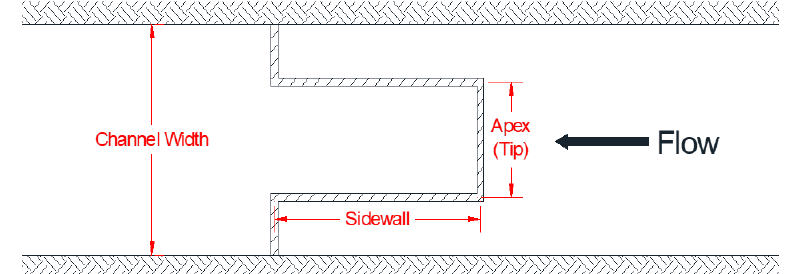
Figure 1. A typical sketch of a rectangular labyrinth weir.